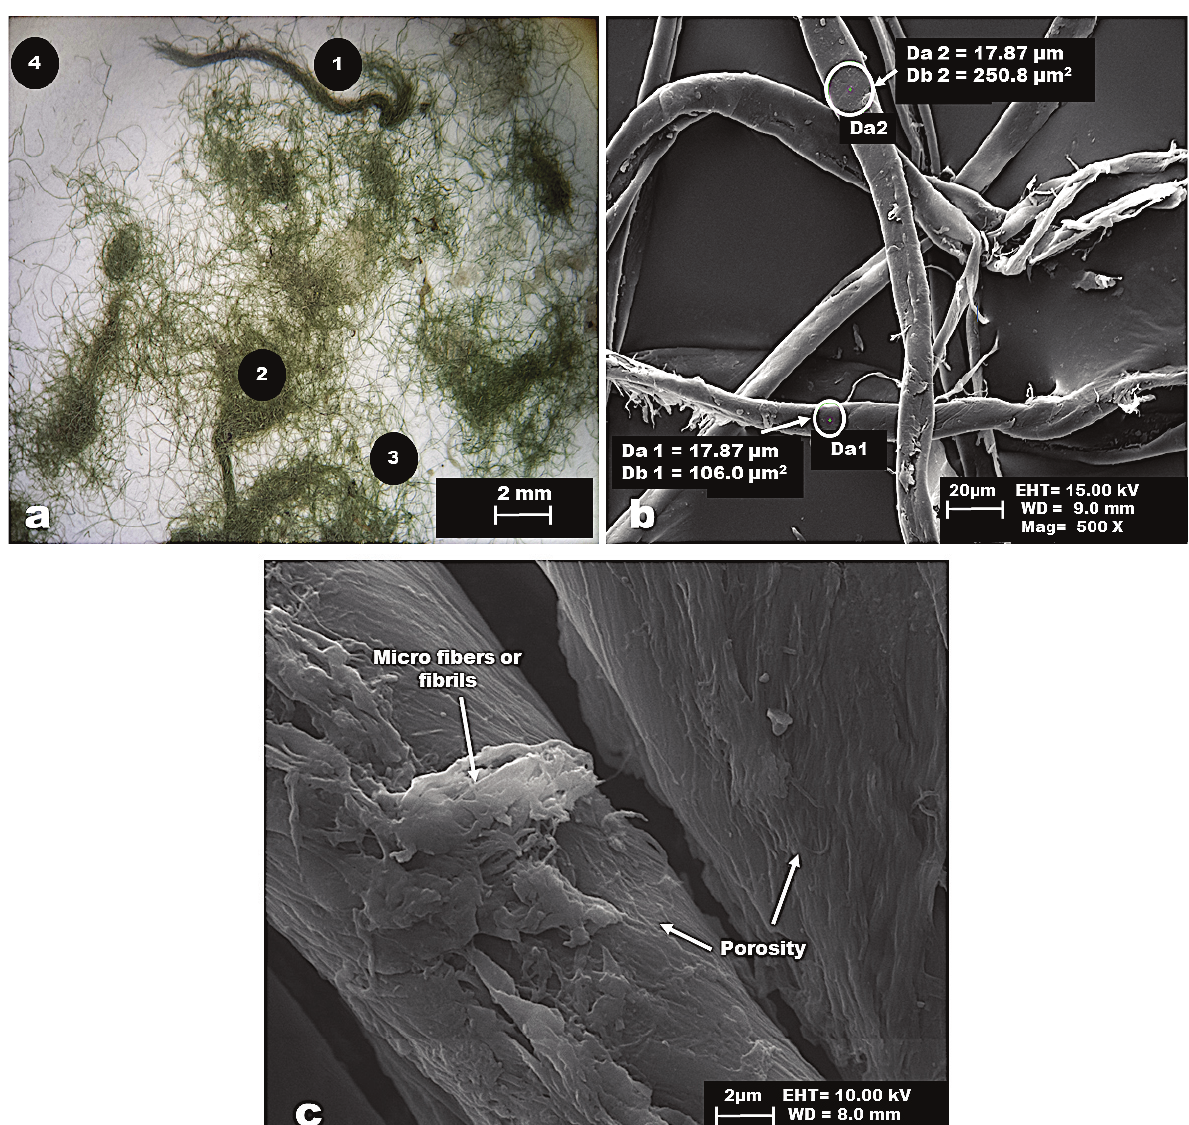
Fig. 2. Ground cotton fibers: (a) binocular optical image, (b) SEM image, (c) microfibrils and porosity on fibre